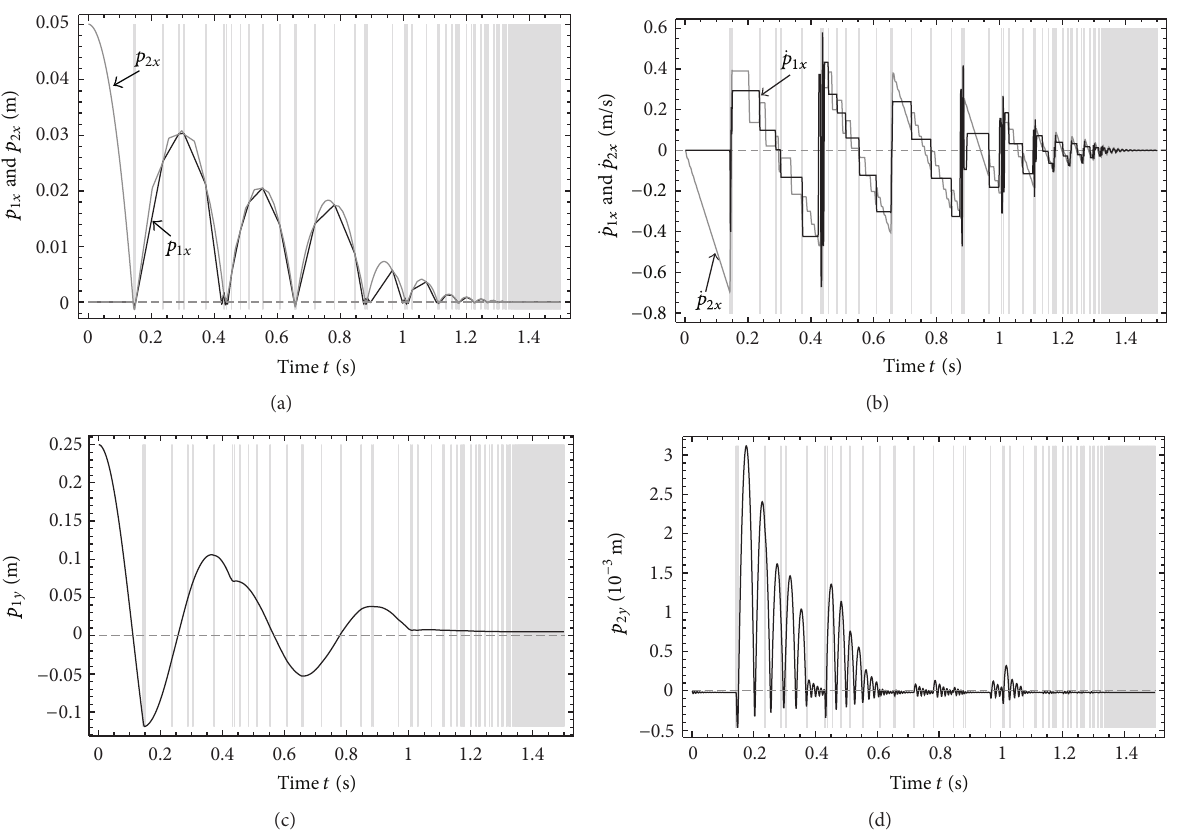
Figure9:SimulationresultsofExampleIIbyusing(45)integratedbyRK4withtimestepsize0.001 s.Thegrayregionsindicatethetimeperiods in which the objects 𝑀 1 and 𝑀 2 are in contact with each other. The parameters are chosen as 𝐾 𝑖 = 5×10 5 N/m, 𝛽 𝑖 = 2×10 −3 s (∀𝑖 ∈ {1,...,6}) , and 𝛼 𝑖 = 1.6 × 10 −3 s (∀𝑖 ∈ {1, 2,3})